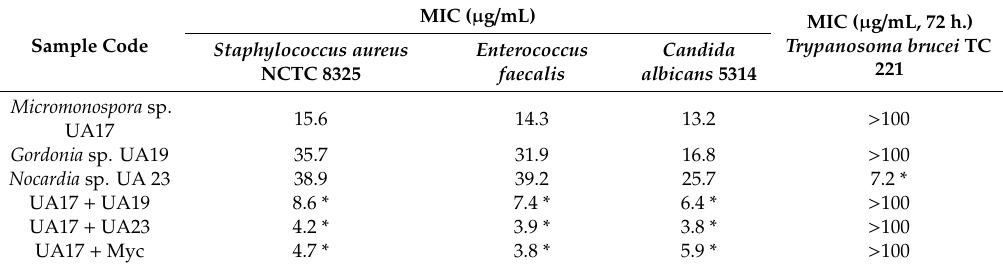
Table 4. Results of the crude extracts of the actinobacterial monoculture extracts ( Micromonospora sp. UA17, Gordonia sp. UA19, and Nocardia sp. UA 23), beside co-cultures with two strains of mycolic acid-containing bacteria ( Gordonia sp. UA19, and Nocardia sp. UA 23) and monocultures amended with mycolic acid against Staphylococcus aureus NCTC 8325, Candida albicans 5314, and Trypanosoma brucei TC 221.